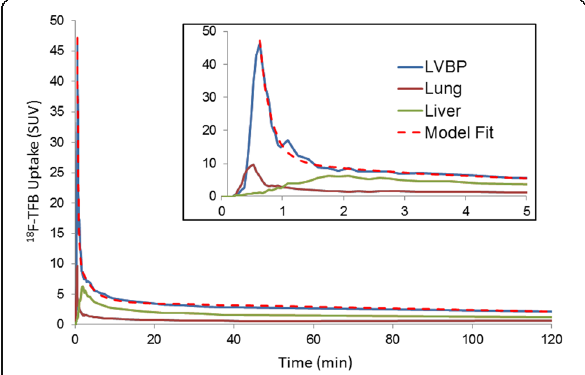
Fig. 2 Time-activity curves of 18 F-TFB in healthy male participant. LVBP left-ventricular blood pool. Inset shows first 5 min of data. The